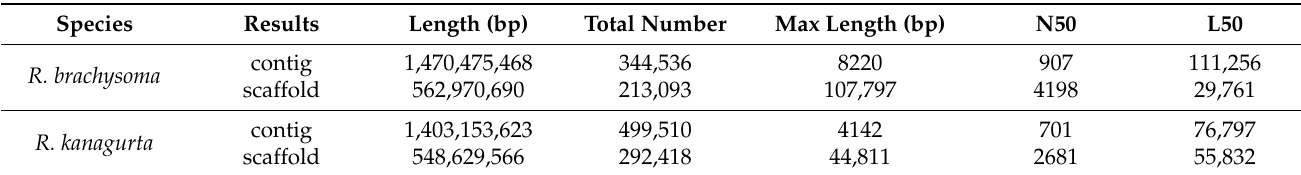
Table 2. Genome assembly statistics for R. brachysoma and R. kanagurta